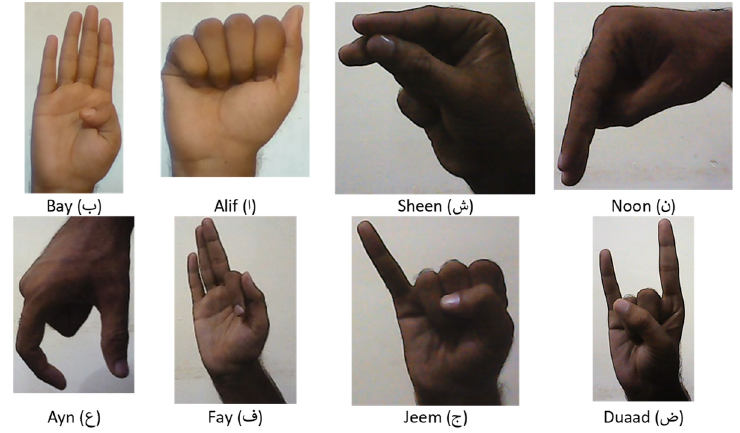
Figure 7. A subset of the American sign language dataset.